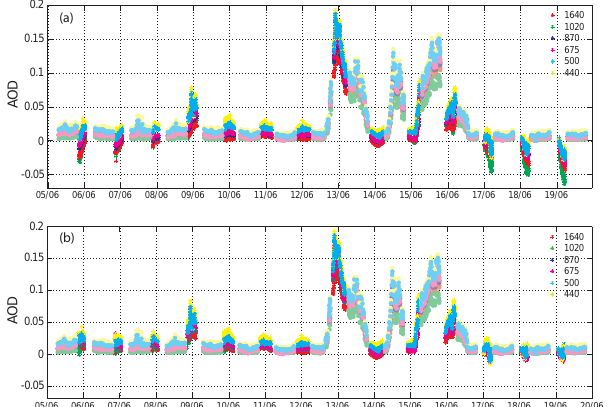
Figure 7. AOD evolution for one Moon cycle (June 2014) at Izaña. Opaque colors represent daylight data. Nocturnal AOD be- fore (a) and after (b) correction is plotted.